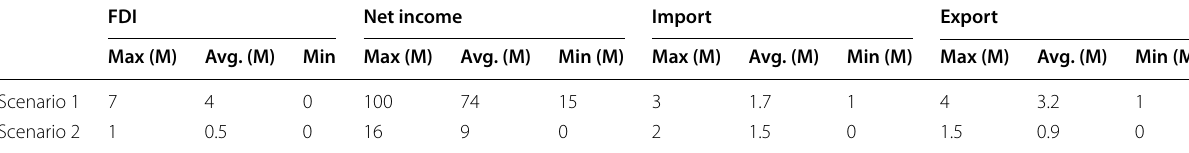
Table 2 Simulation results of scenario analysis based on the 95% confidence interval